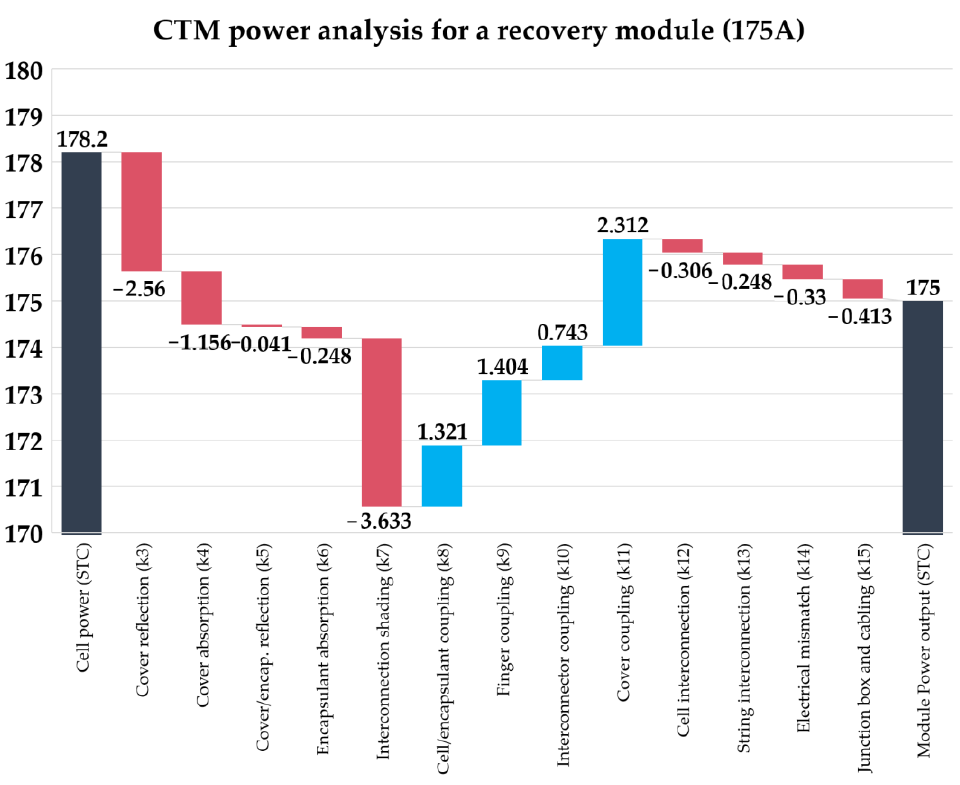
Figure 3. Initial output of cell calculated by CTM power analysis method.